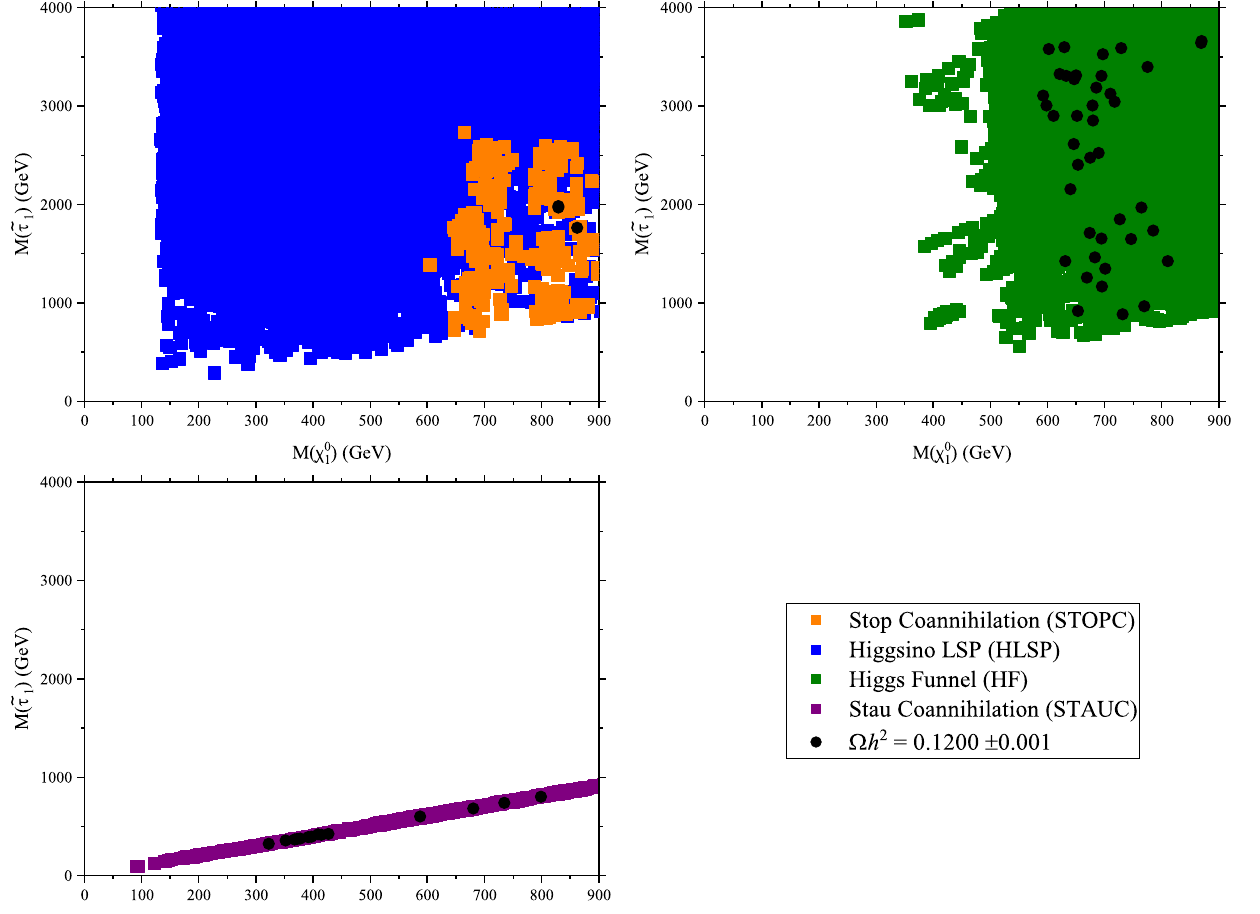
sity observations we outlined in this work, in addition to rare decay and current LHC SUSY search constraints. The round black dots represent those points that can also satisfy the recent 2018 Planck Collaboration satellite relic density measurements of (cid:9) h 2 = 0 . 120 ± 0 .